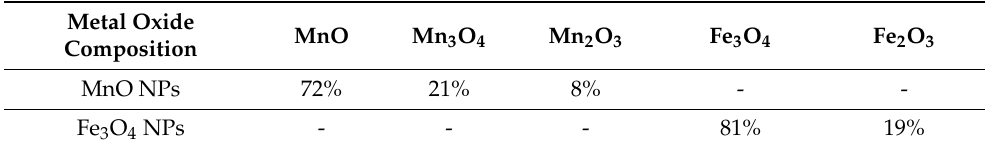
Table 1. Percent composition of the first synthesized batches of bare metal oxide NPs from X-Pert HighScore.